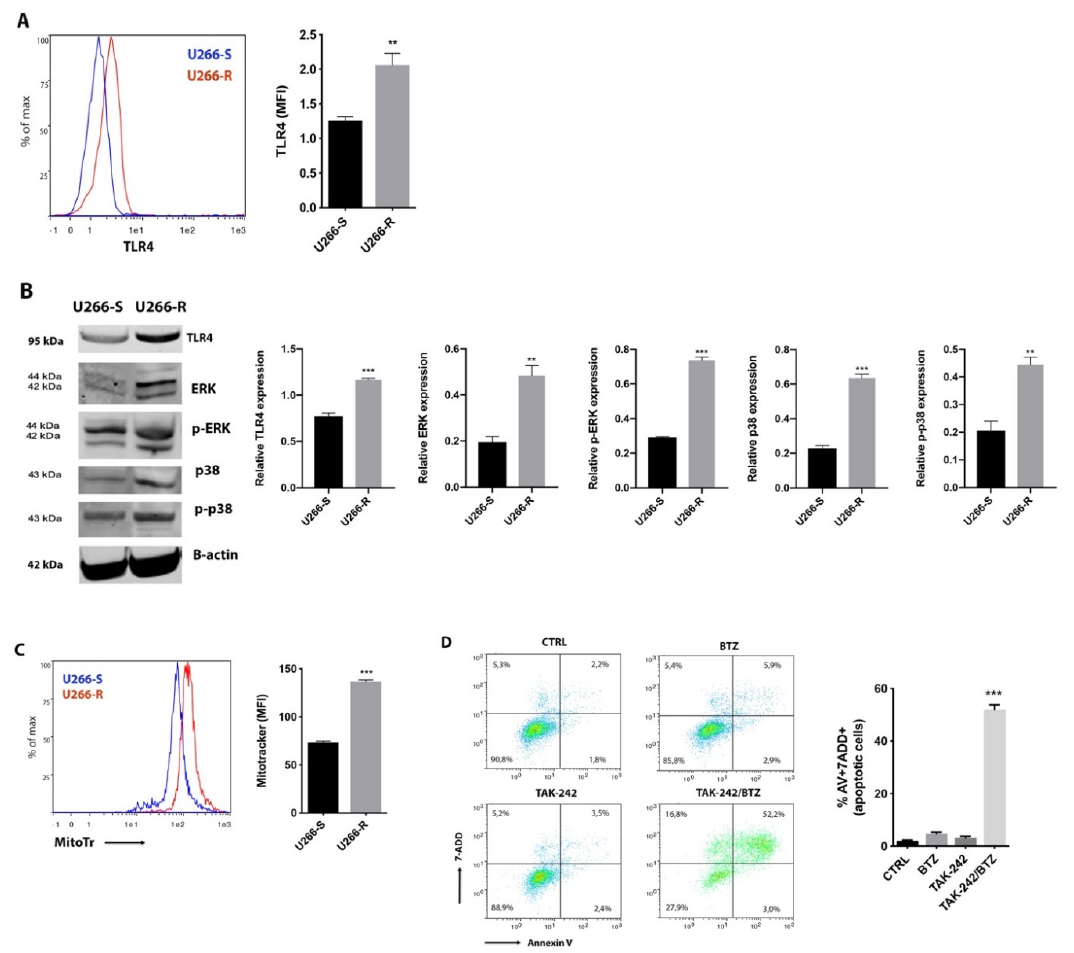
Figure 3. Combined treatment with TLR4 inhibitor and BTZ overcame proteasome inhibitors (PI) resistance and induced apoptosis in U266-R. ( A ) A representative histogram of a flow cytometric analysis showing U266-S (blue line) and U266-R (red line) stained with anti-TLR4 antibody. The TLR4-mean fluorescence intensity (MFI) was calculated and plotted. ( B ) Western blot analysis of TLR4, ERK, p-ERK, p38 and p-p38 in U266-S vs. U266-R. β -actin protein was used as total protein loading reference. For analysis of Western blot, the optical density of the bands was measured using Scion Image software. ( C ) Mitochondrial mass was analyzed using Mitotracker staining. A representative histogram for U266-S (blue line) and U266-R (red line) is shown and Mitotracker-MFI analysis is plotted. ( D ) Representative dot plots of the e ff ect of TAK-242 / BTZ treatment on the viability of U266-R cells is shown (left panel). The graph (right panel) shows the mean values of the percentage of apoptotic cells after annexin-V-FITC and 7-ADD staining. All results shown represent the means of four independent experiments; bars indicate the standard error means. ** p < 0.01; *** p < 0.001.